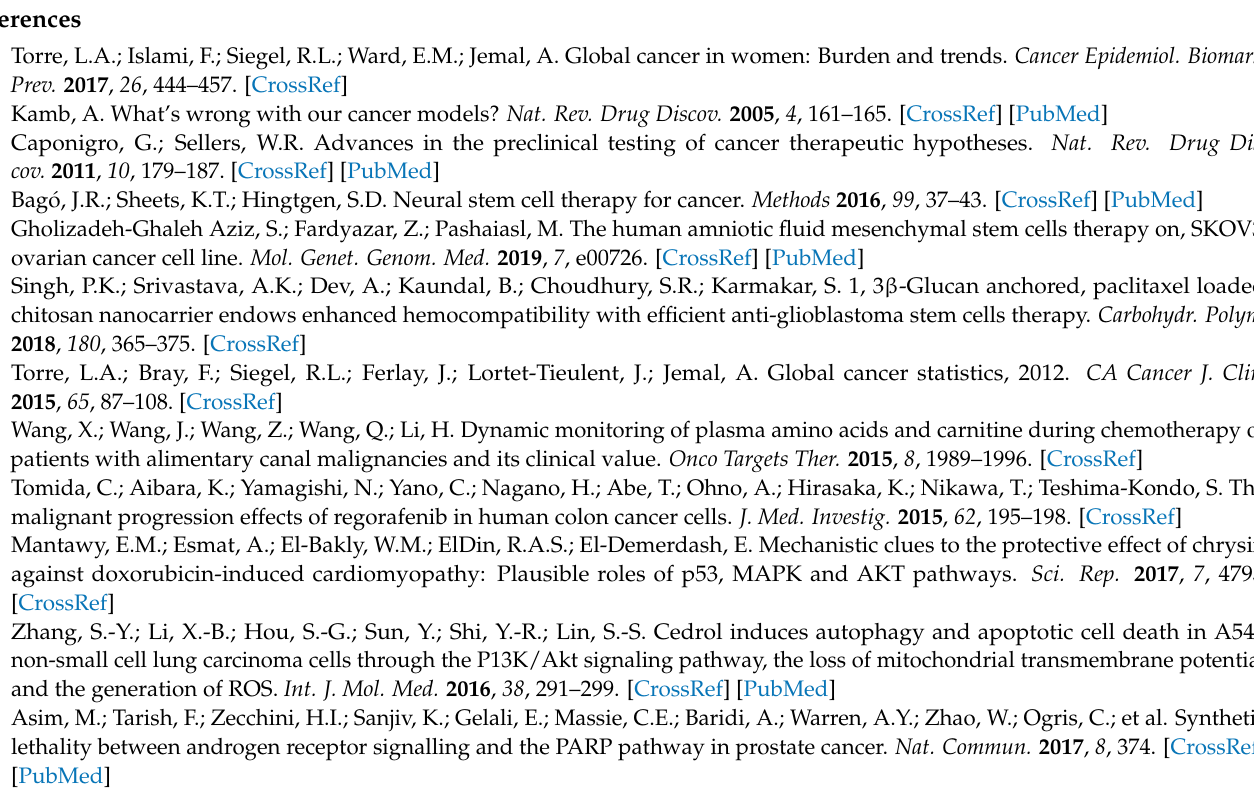
Figure S2: MCF-7 Western Blotting; Figure S3: RKO Western